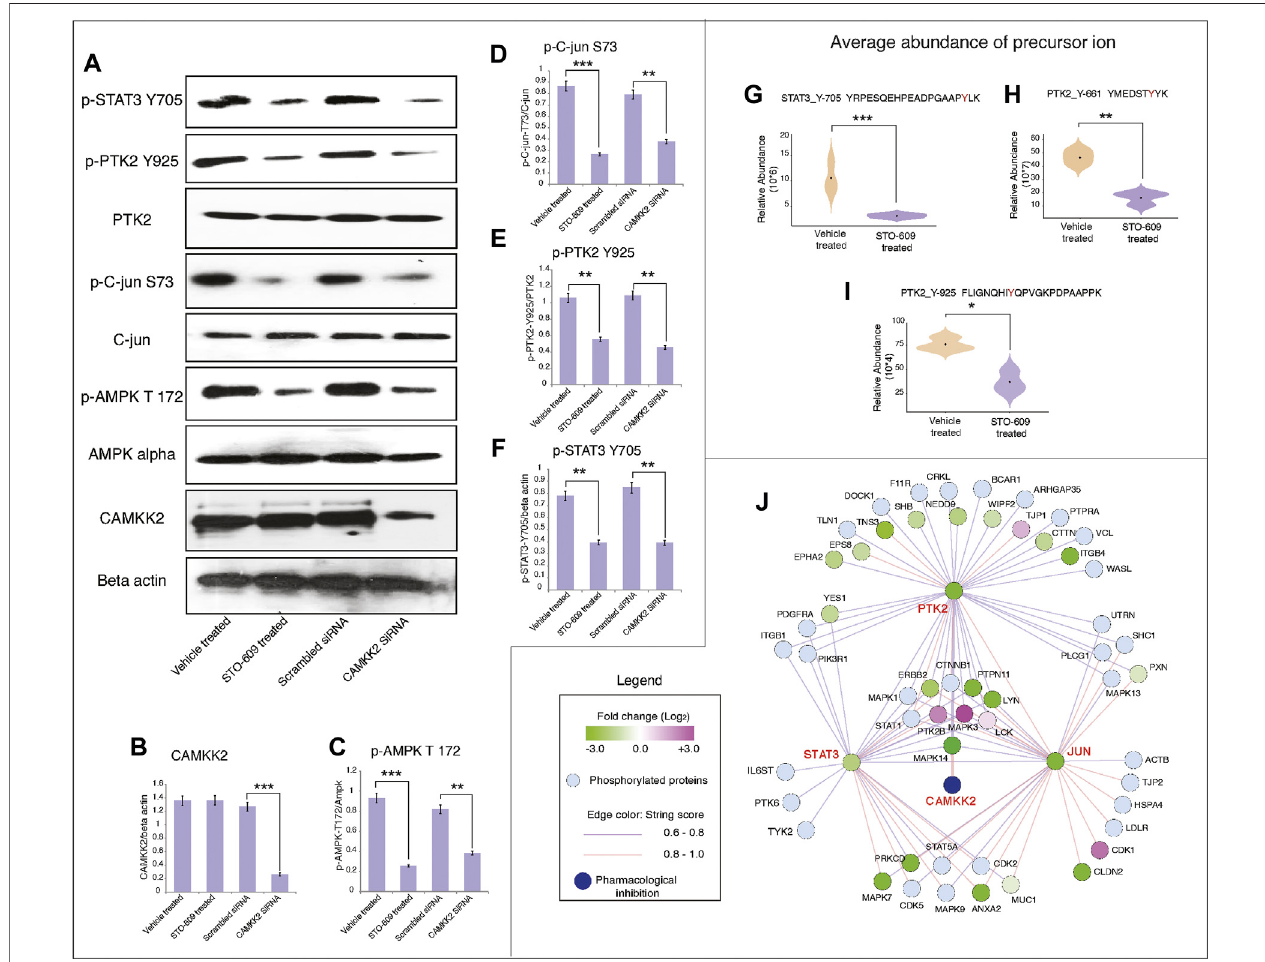
FIGURE 6 | Inhibition of CAMKK2 decreased phosphorylation of PTK2/c-JUN and STAT3 signaling in gastric cancer cells. (A) Expression of indicated proteins in gastric cancer cells (AGS) on inhibition or silencing of CAMKK2 as indicated; β -Actin was used as a loading control. (B) Densitometry graph representing the expression of CAMKK2 for conditions depicted in (A) (*** p < 0.001). (C) Densitometry graph representing the expression p-AMPK depicted in (A) (** p < 0.01, *** p < 0.001). (D) Densitometry graph representing the expression p-c-JUN depicted in (A) (** p < 0.01, *** p < 0.001). (E) Densitometry graph representing the expression p-PTK2 depictedin (A) (** p < 0.01). (F) Densitometrygraphrepresentingtheexpressionp-STAT3depictedin (A) (** p < 0.01). (G – I) Violinplotshowingtheexpressionofp-STAT3 and p-PTK2 from mass spectrometry data. (J) Network analysis of hypophosphoproteins in AGS cells upon CAMKK2 inhibition using the STRING (Version 11:0)